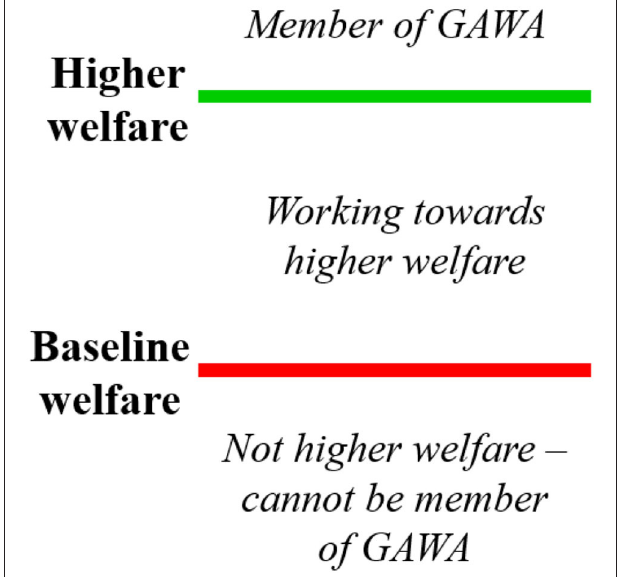
FIGURE 7 | Schematic of the working model of the frameworks for Global Animal Welfare Assurance (GAWA).